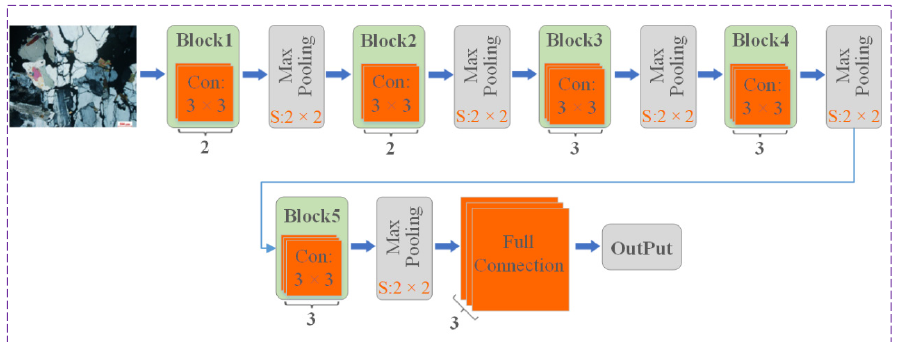
Figure 4. VGG16 architecture. Table 10. Detailed descriptions of the validated datasets.